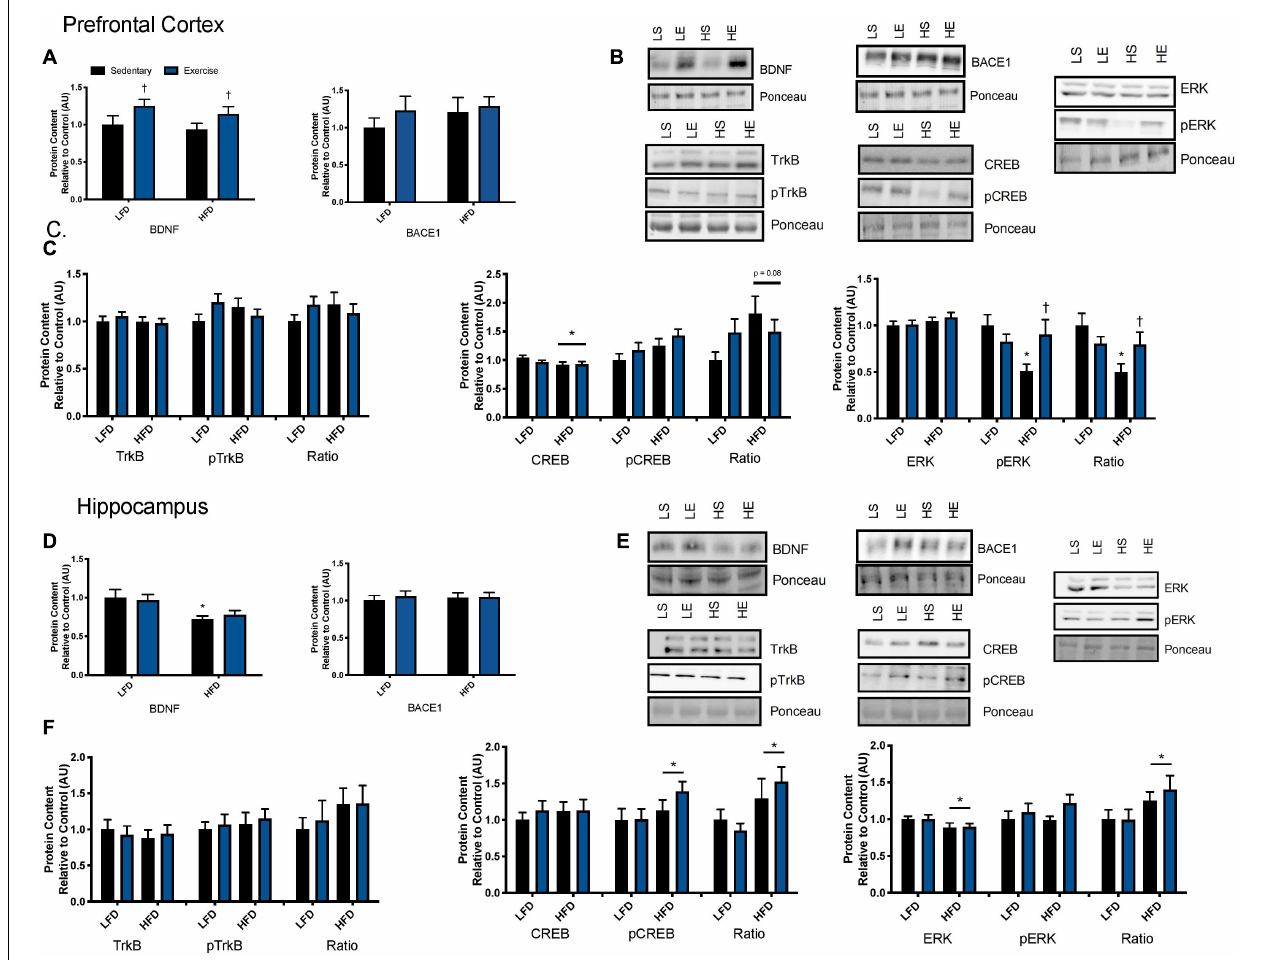
FIGURE 5 | Exercise induced BDNF signaling. (A) An acute bout of exercise increased BDNF total protein content in the prefrontal cortex, however, there were no changes in BACE1 content. (B) Representative blots for downstream markers of BDNF signaling in the prefrontal cortex. (C) There were no effects of diet or acute exercise on TrkB, total CREB content was reduced with a HFD, and phosphorylated ERK was significantly lower with a HFD, however, phosphorylated ERK was recovered with a single bout of exercise, represented as an absolute value and relative to total content in the prefrontal cortex. (D) BDNF content was lower with the HFD in the hippocampus and no effect of exercise, there were no changes in BACE1 content. (E) Representative blots for downstream markers of BDNF signaling in the hippocampus. (F) There were no effects of diet or acute exercise on TrkB, CREB phosphorylation was higher with a HFD represented as both an absolute value and as a ratio to total content, and total ERK was reduced with a HFD and the ratio of pERK/ERK was significantly higher in the HFD group in hippocampus. Values are represented as mean ± SEM. Significance indicated by * p < 0.05 compared to LFD, † p < 0.05 compared to sedentary. Western blots have been cropped to provide a representative